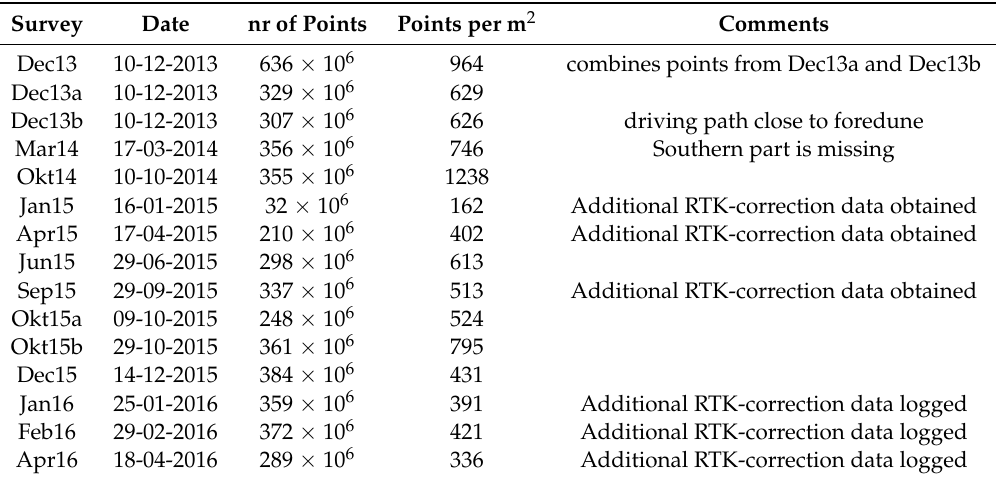
Table 1. MLS survey